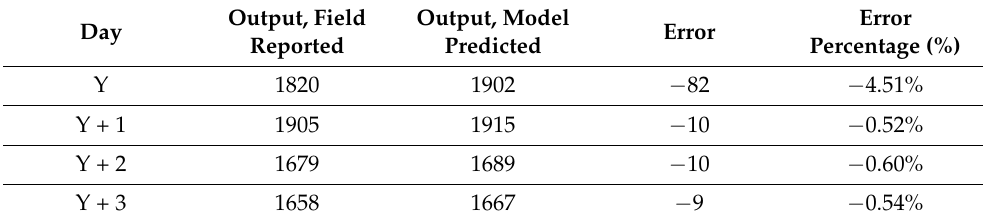
Table 6. The prediction accuracy of the gnLSTM model with a15 min data training on day Y.